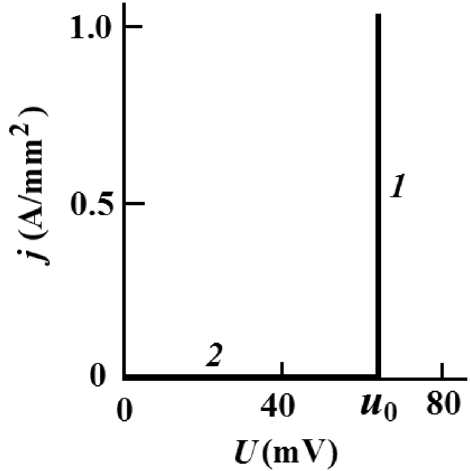
Figure 2. Current—Voltage characteristic of the metal-powder-metal system. 1 before and 2 after change on the electrodes voltage polarity U ; j is the current density; U is the voltage between the electrodes; u 0 = u 1 + u 2 is the sum of the contact potential differences of the powder with the electrodes. The powder is in the stable polarized